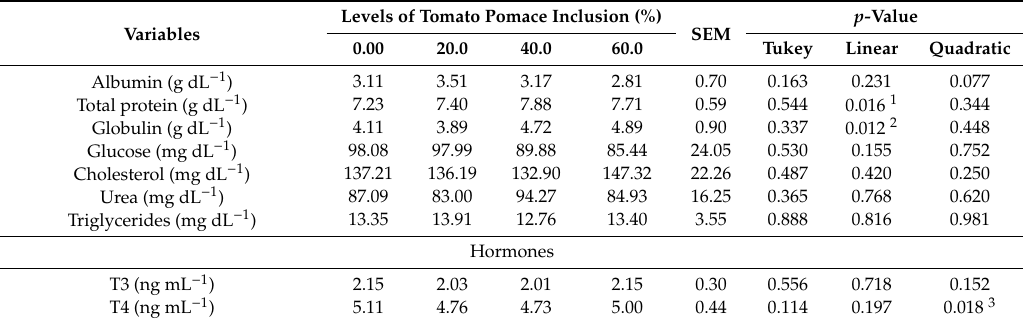
Table 5. Blood biochemical parameters and hormones of dairy goats fed with di ff erent levels of inclusion of tomato